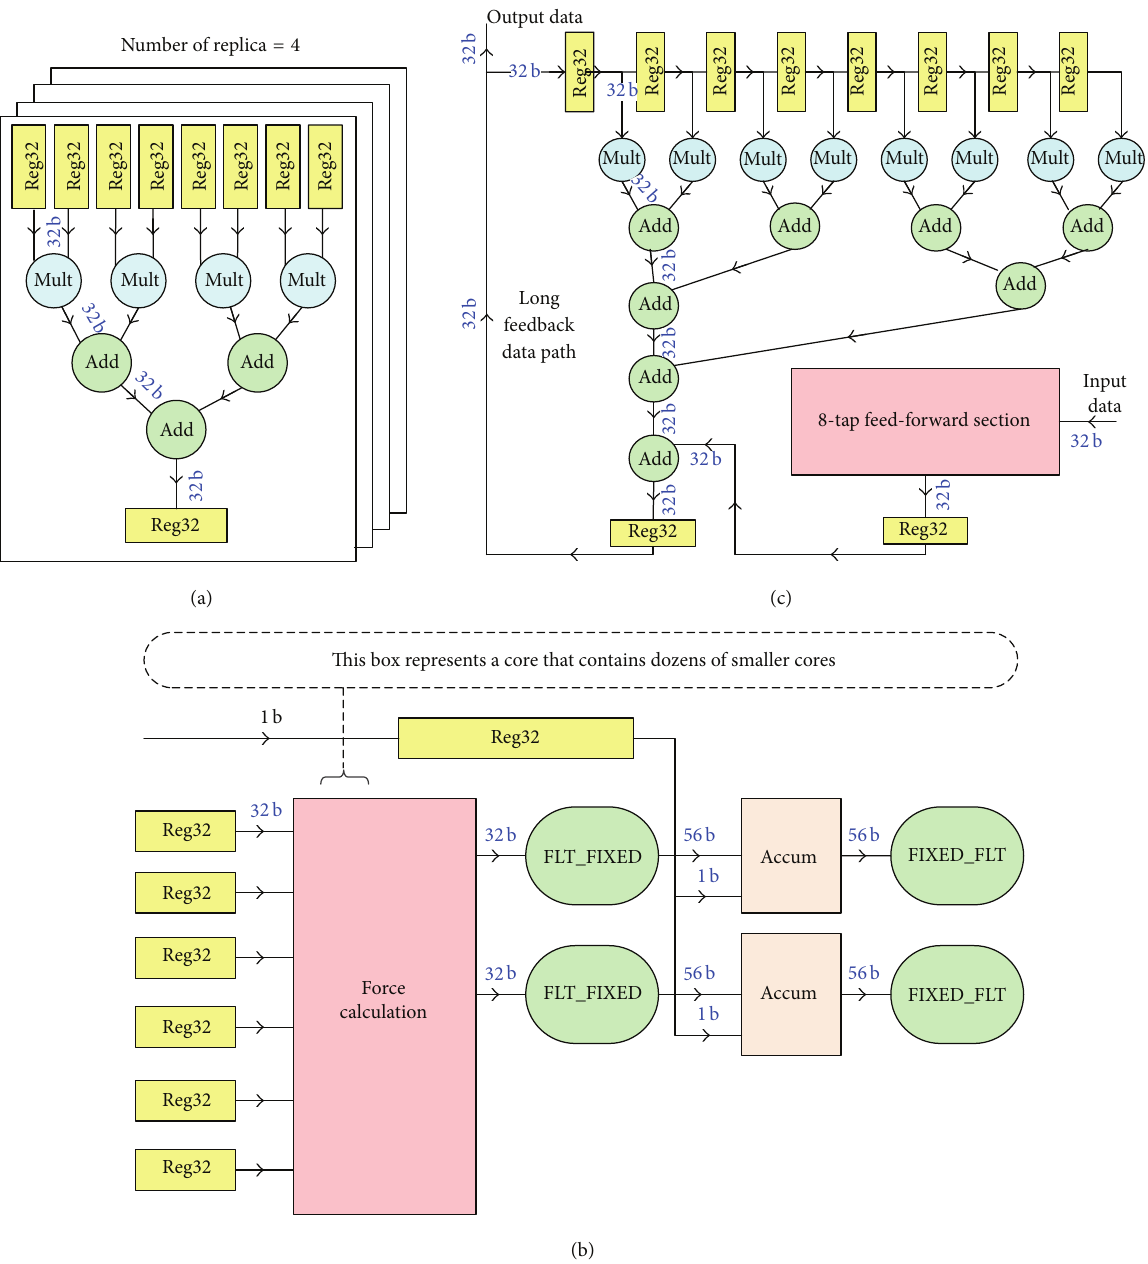
Figure 12: Core-level models of case-study applications: (a) 4 × 4 matrix multiply, (b) N-body simulation, and (c) 8-tap SPFP IIR filter.